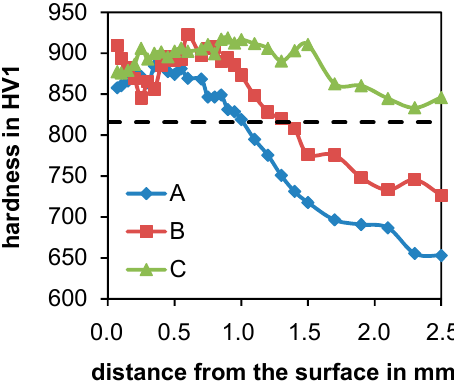
Figure 6. Hardness profiles after carbonitriding of the material X38CrMoV5-3 with different process management (for heat treatment parameters of A, B and C see Table 2).